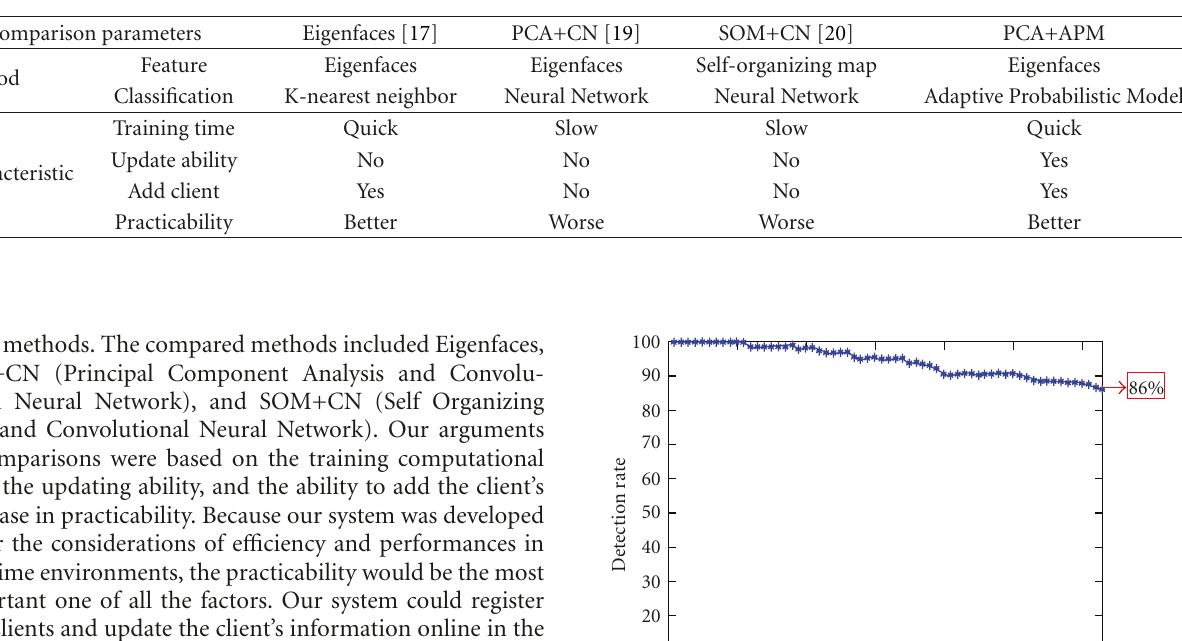
Table 2: The comparison of characteristics for the proposed method and others.